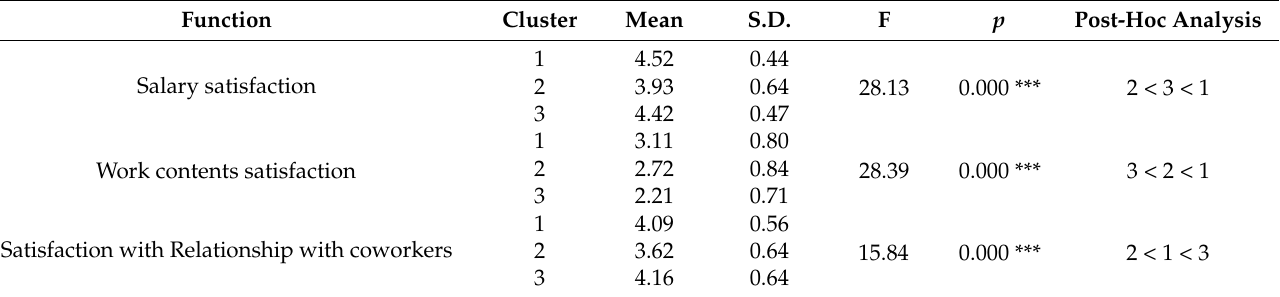
Table 7. Results of differences of job satisfaction by cluster.